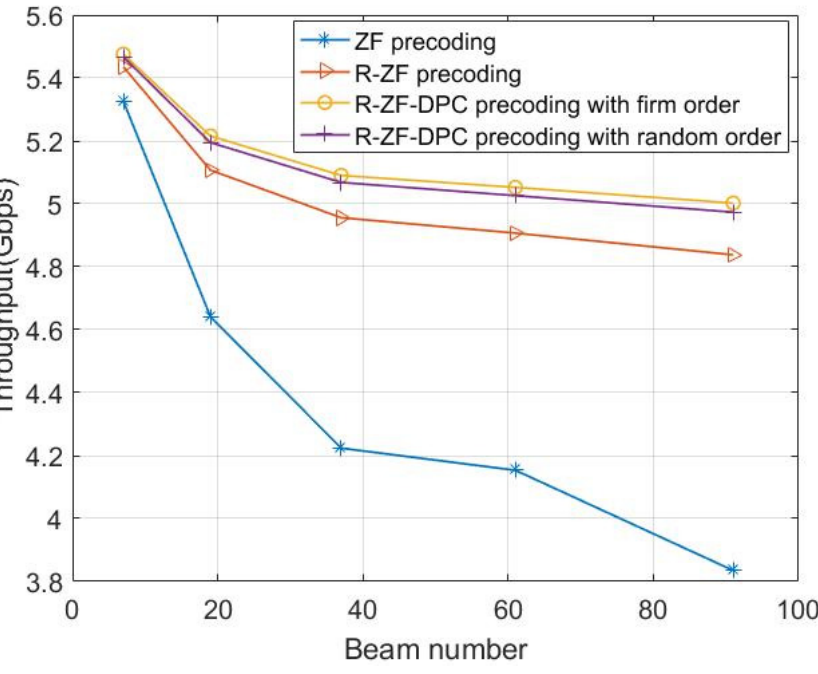
Figure 5. Influence of beam number on throughput per beam of four precoding schemes.